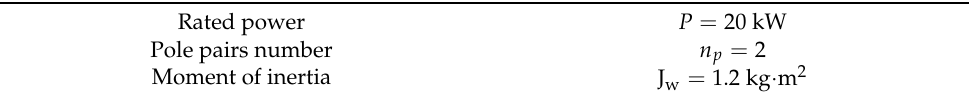
Table A3. Wind system parameters